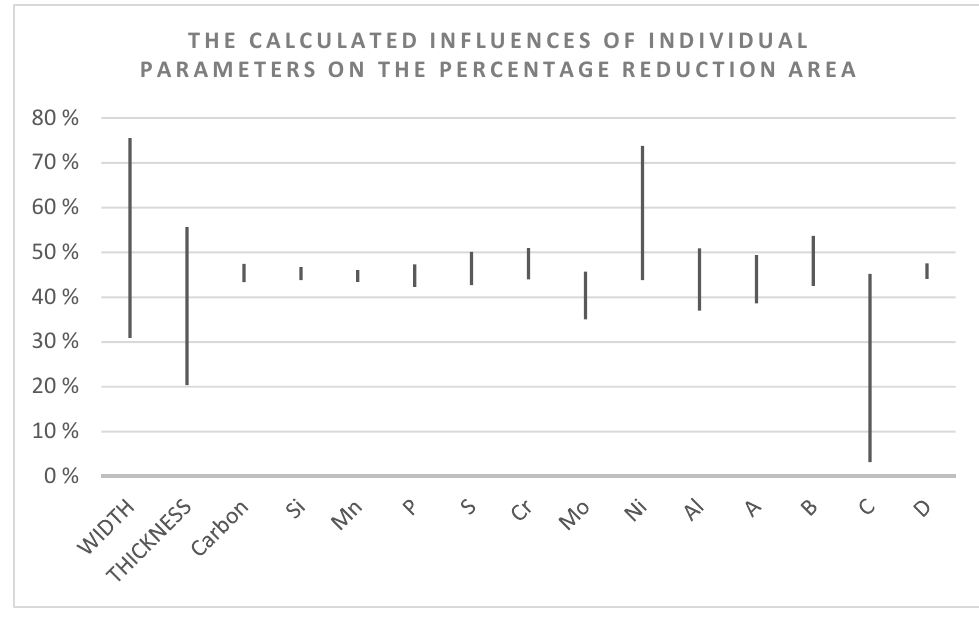
Figure 5. The calculated influences of individual parameters on the percentage reduction area while separately changing individual parameter within the individual parameter